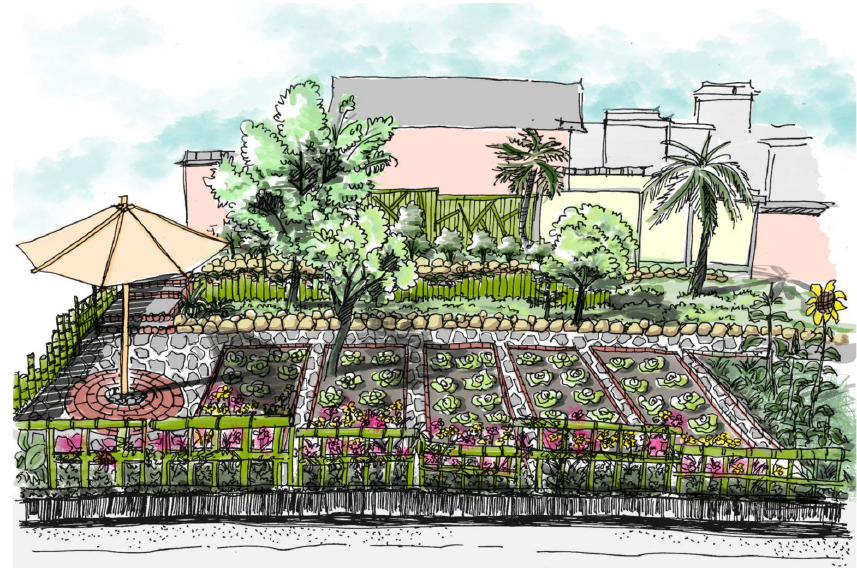
Figure 7. The design rendering of farmyards in one case study site in Hongtang Village. Source: the authors.